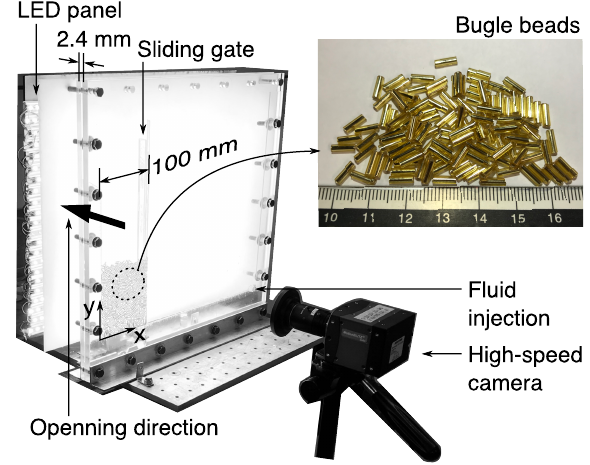
Figure 1. Planar column setup of a dry column collapse and a close-up view of the elongated